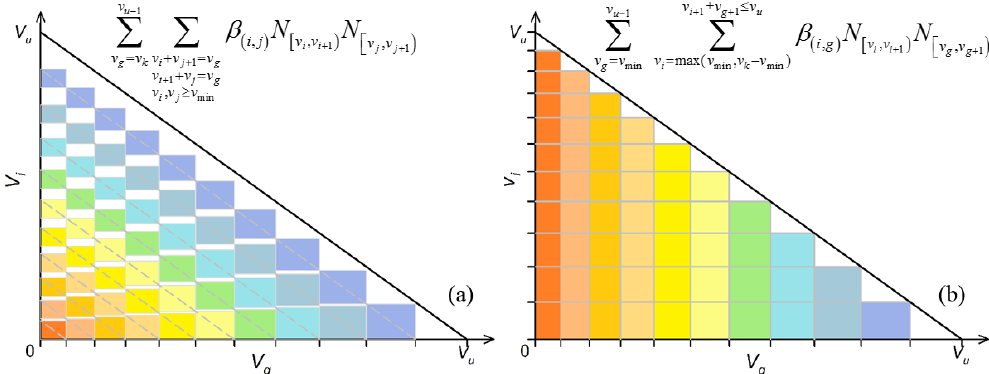
Figure A1. Schematic for two different summation sequences to estimate the coagulation source term. Equations in panels (a) and (b) correspond to the continuous forms on the far LHS and the far RHS formulae in Eq. (A7), respectively. The coagulation source term is denoted by half the area of the triangle (since the particles at the same diameter are accounted for twice). The colored areas are the estimated area using the two equations. The summation terms corresponding to the same particle volume, v g , are shown in the same color. The coagulation source term is underestimated in panel (a) because v g increases nonlinearly in this case, whereas the estimated coagulation source term is independent of the bin structures for d g and d i in panel (b)